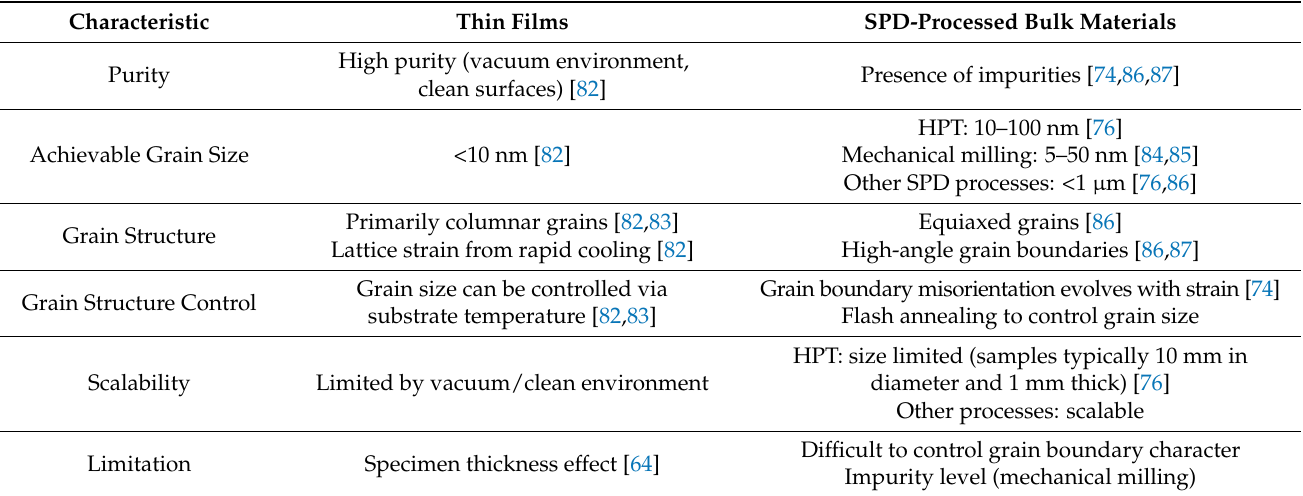
Table 2. Comparison of thin films and SPD-processed bulk